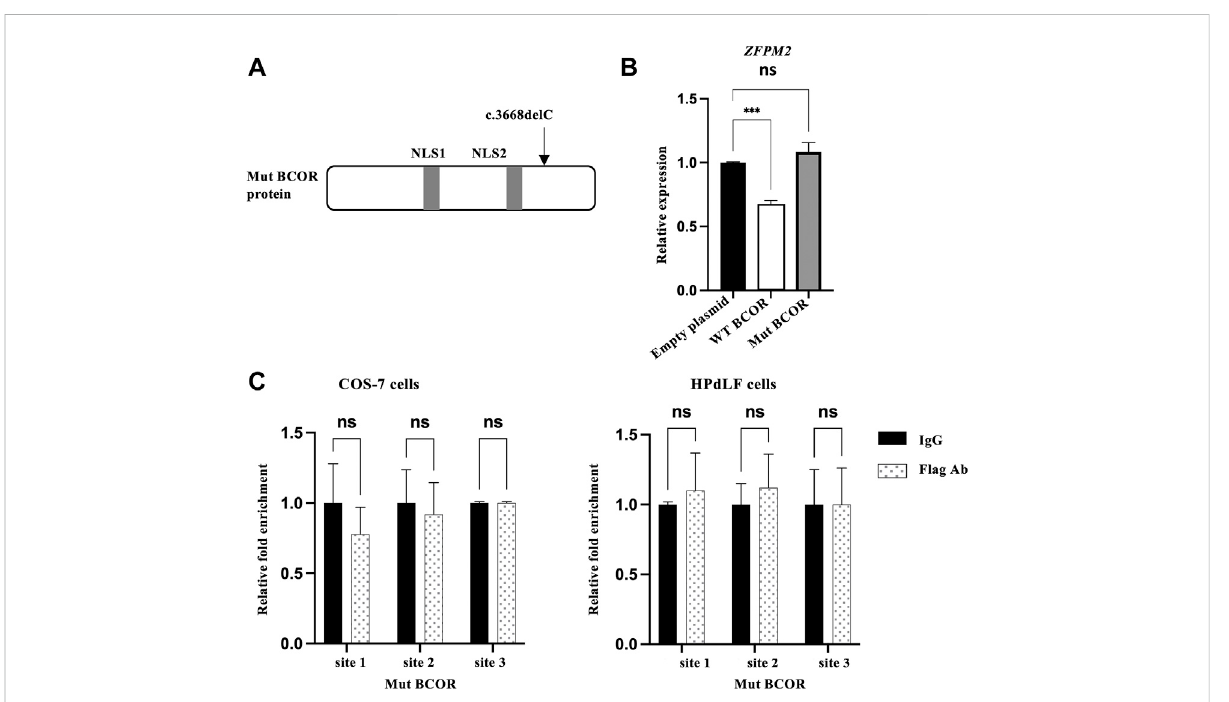
FIGURE 3 Mut BCOR failed to bind the BCL6 promoter sites on ZFPM2. (A) The Mut BCOR plasmid (c.3668delC) have a nuclear localization signal (NLS1andNLS2),whichisthesamegenotypeasthatofourpatientfromourpreviousresearch. (B) ExpressionofZFPM2mRNAafterWTorMutBCOR overexpression in HPdLF cells. WT BCOR repressed ZFPM2 expression, but Mut BCOR did not. t -test, *** p < 0.001; ns, not signi fi cant. (C) ChIP assay for the occupation of BCL6 on the promoter of ZFPM2 in Mut BCOR-overexpressed COS-7 cells and HPdLF cells. Mut BCOR failed to bind